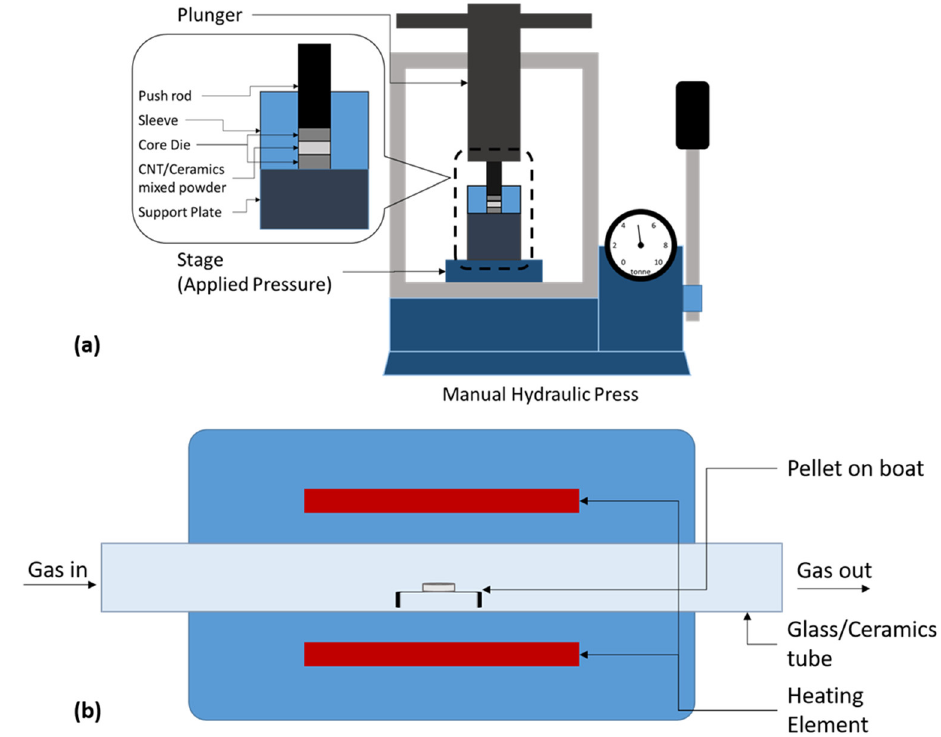
Figure 13. Schematic setup of pressureless sintering, a two-step densification. ( a ) Powder to pellet through uniaxial pressing and ( b ) gas-filled sintering of pellet.